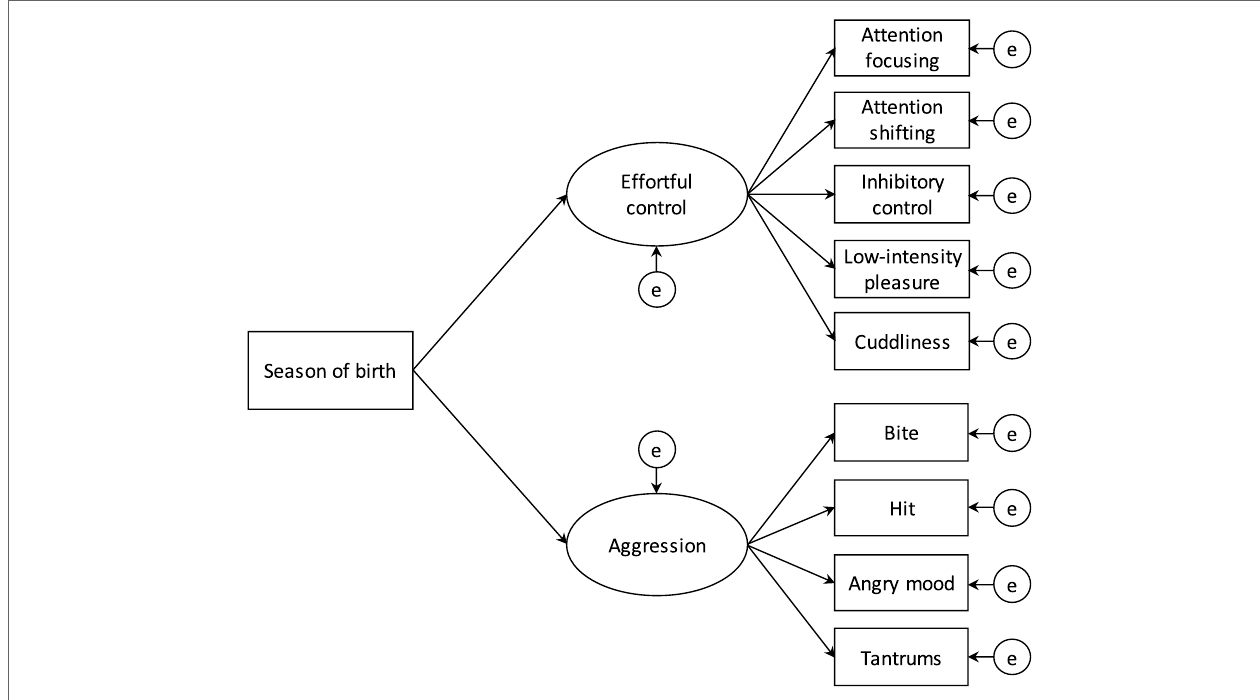
FigUre 1 | structural equation modeling for the effects of birth season on effortful control and aggression in 18-month-old infants